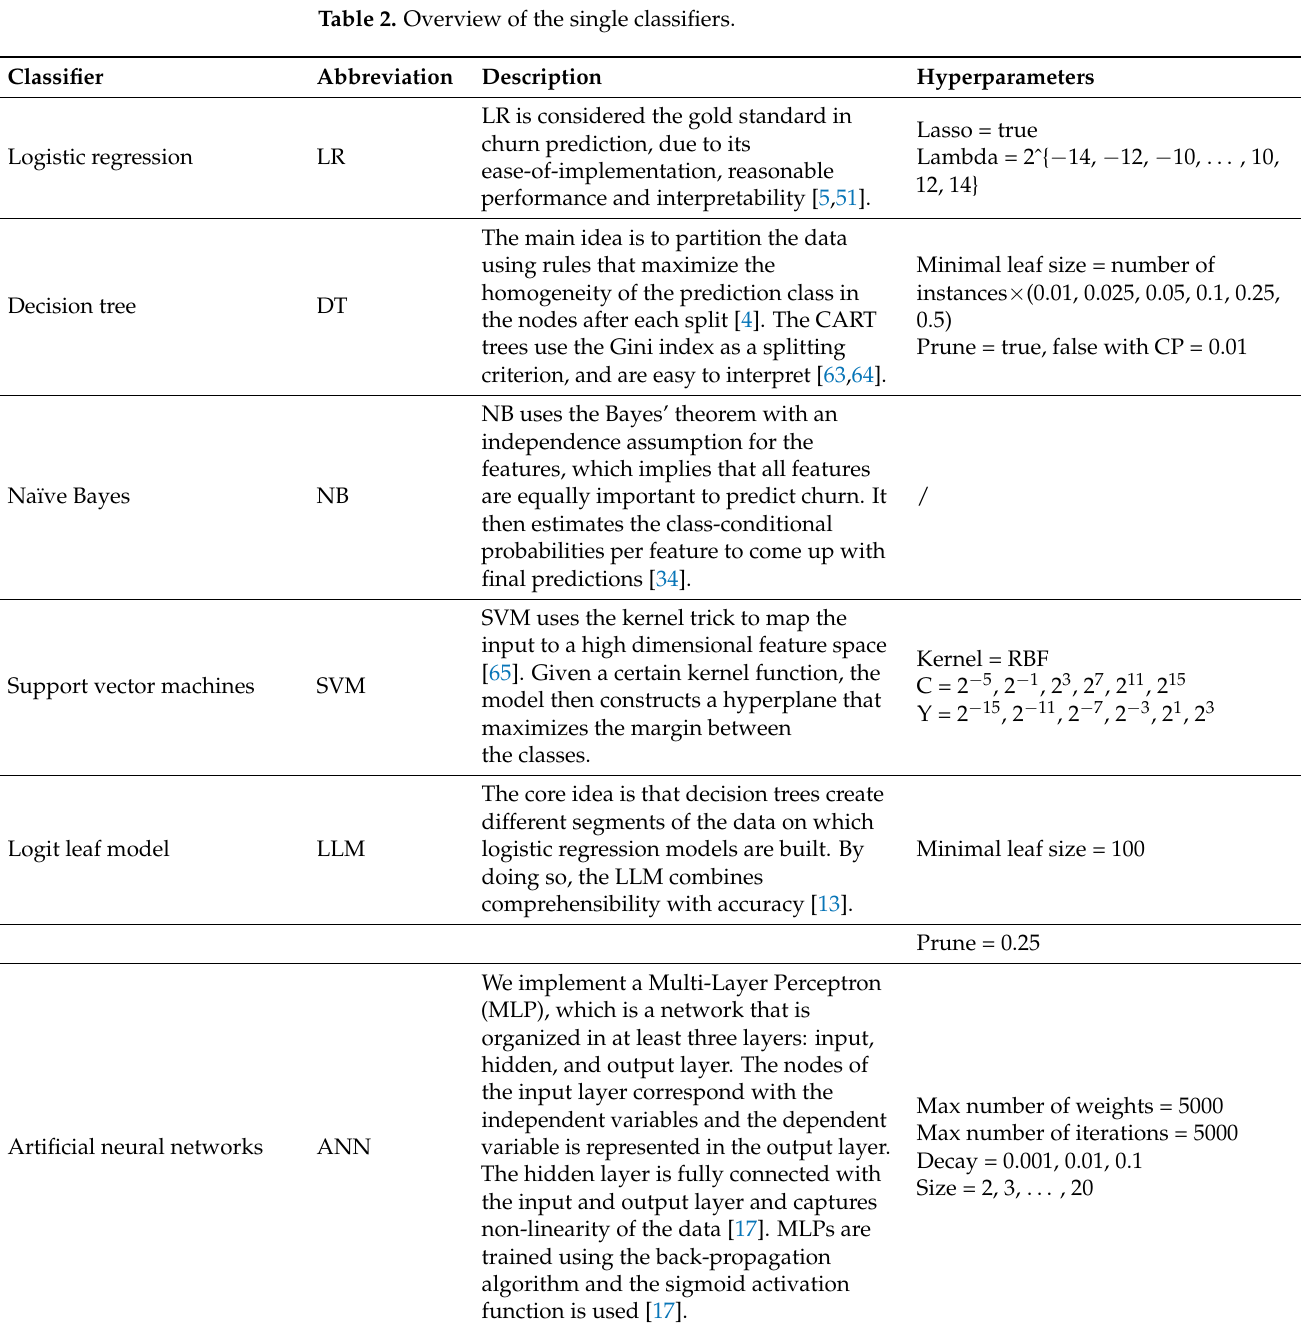
Table 2. Overview of the single